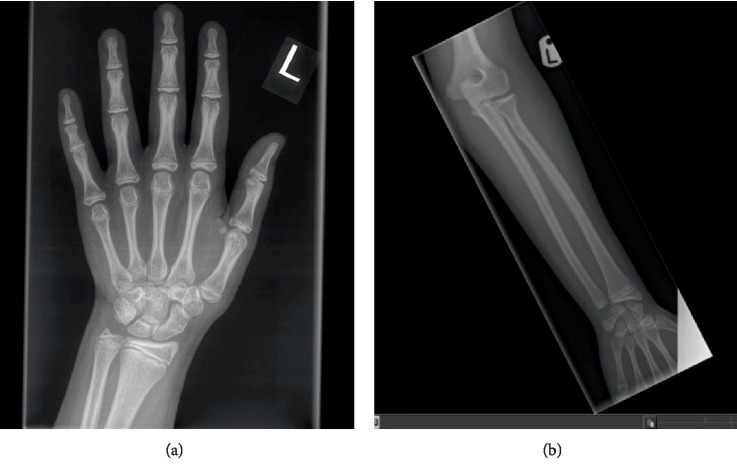
(a and b) Radiographs of A1's left hand and left forearm with changes described in the text.